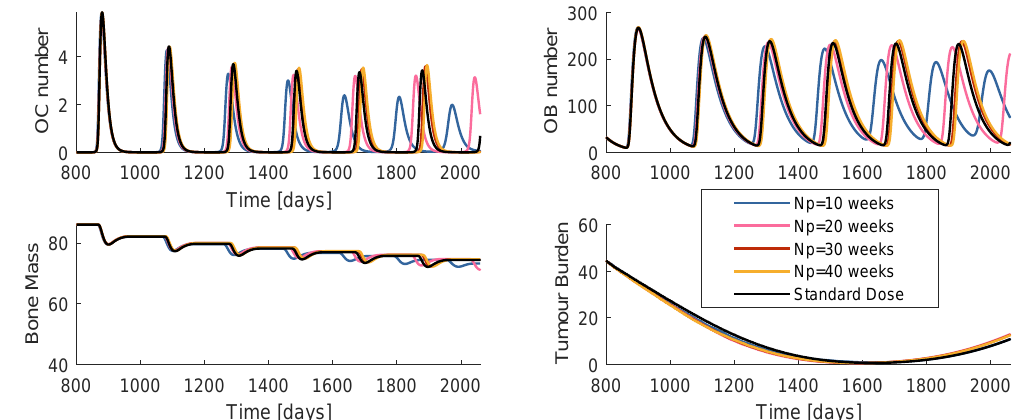
Figure 9. Effects in the system dynamics (treatment phase) when different N p values are used (Model M DR 2 ).